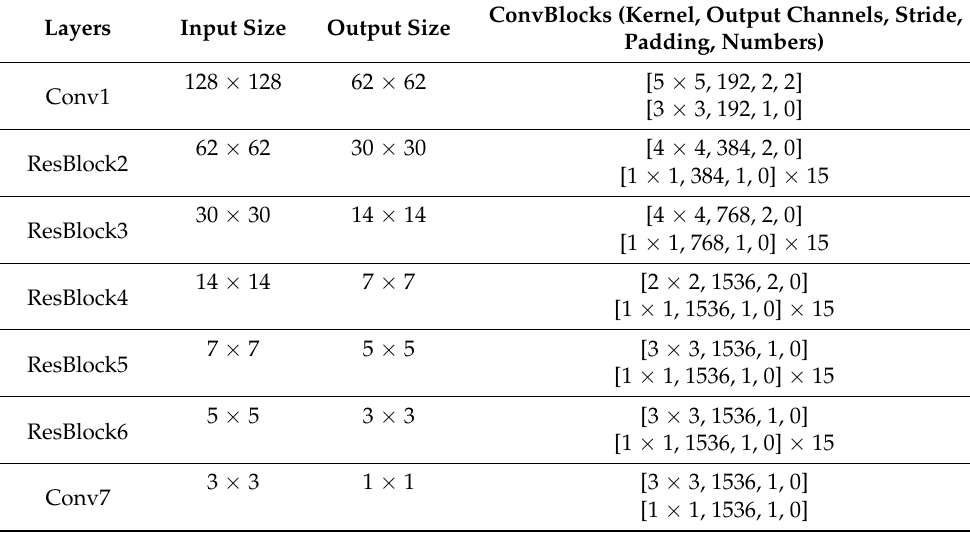
Table 2. Self-supervised learning network